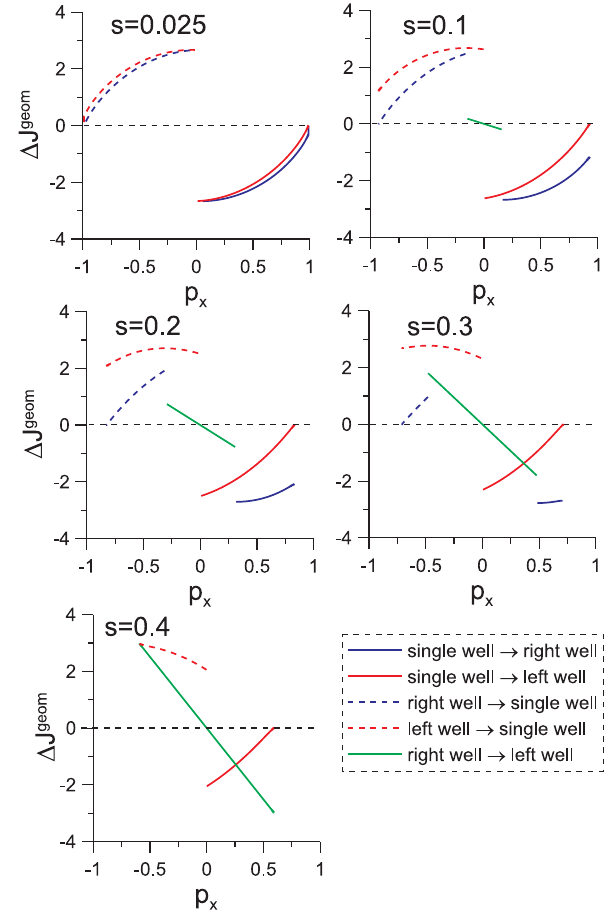
Fig. A1. Geometrical jumps for systems with various s